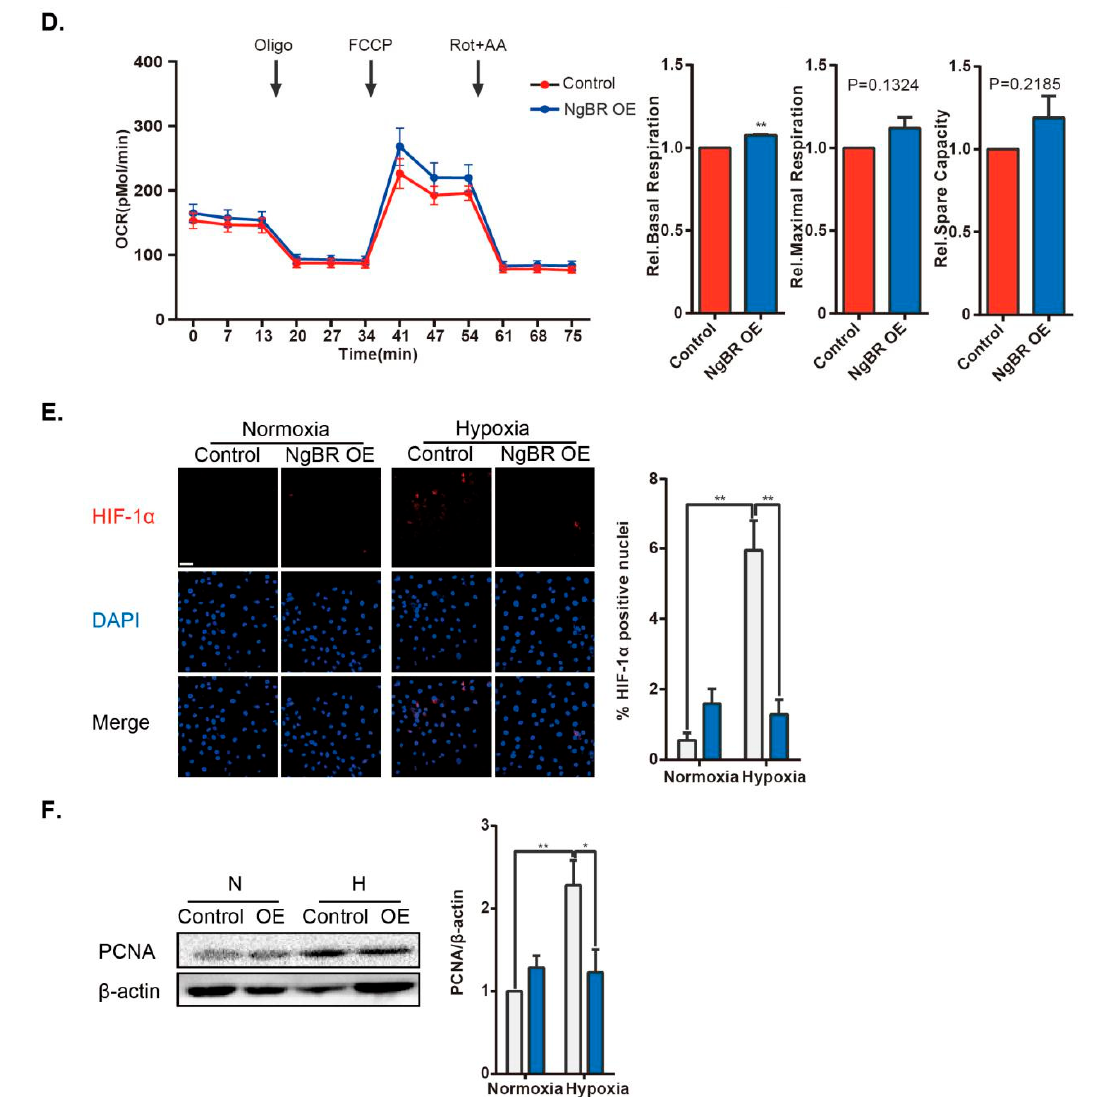
Figure 6. NgBR overexpression (OE) suppresses cell proliferation through enhancing mitochondria-ER communication and reducing phosphorylation of IP 3 R3. ( A ) The transfection e ffi ciency of NgBR OE plasmid was verified at 48 h post transfection. n = 3 ( B ) Representative images from three experiments show phosphorylation of endogenous IP 3 R3 (Akt substrate) in the immunoprecipitates of IP 3 R3 from crude mitochondrial extracts. ( C ) Representative confocal microscopy images show co-staining of Rhod-2 AM (red) and MitoTracker Green (green). Results were calculated as relative AFU using ImageJ. n = 20 pictures / group from four independent experiments. Scale bar = 20 µ m. ( D ) Representative line and bar graphs of OCR of control and NgBR OE cells under normoxia. n = 15–16 wells from three individual experiments. ( E ) Representative confocal microscopy images showing staining of HIF-1 α (red) and DAPI (nuclear stain; blue). Percentage of HIF-1 α -positive nuclei was calculated using FV10-ASW3.1 software. n > 25 pictures / group from three separate experiments. Scale bar = 40 µ m. ( F ) Cell proliferation was assessed by evaluating PCNA expression, n = 4. * p < 0.05, ** p <